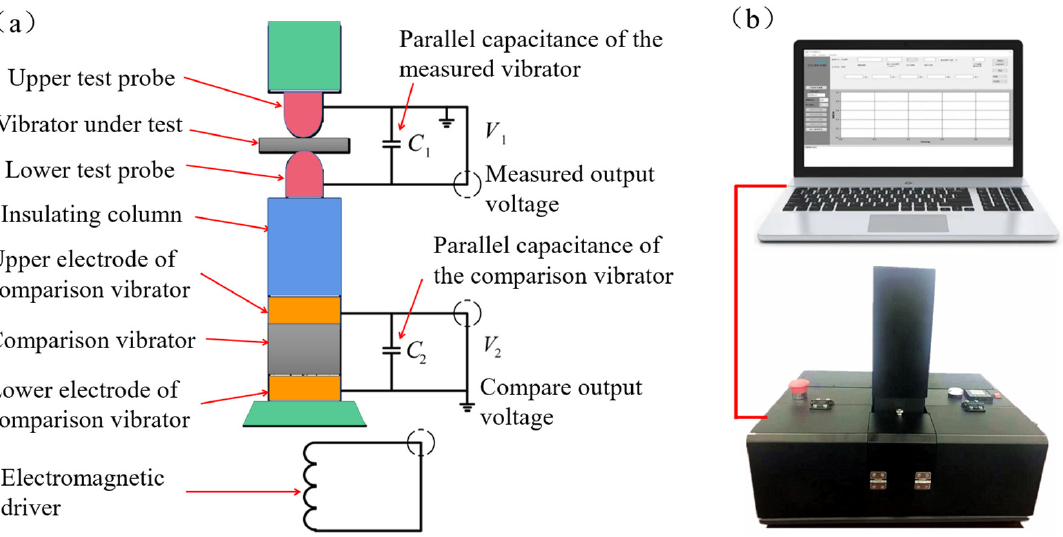
Figure 6. ( a ) Schematic diagram of quasi-static test method; ( b ) piezoelectric coefficient measuring instrument of d 33